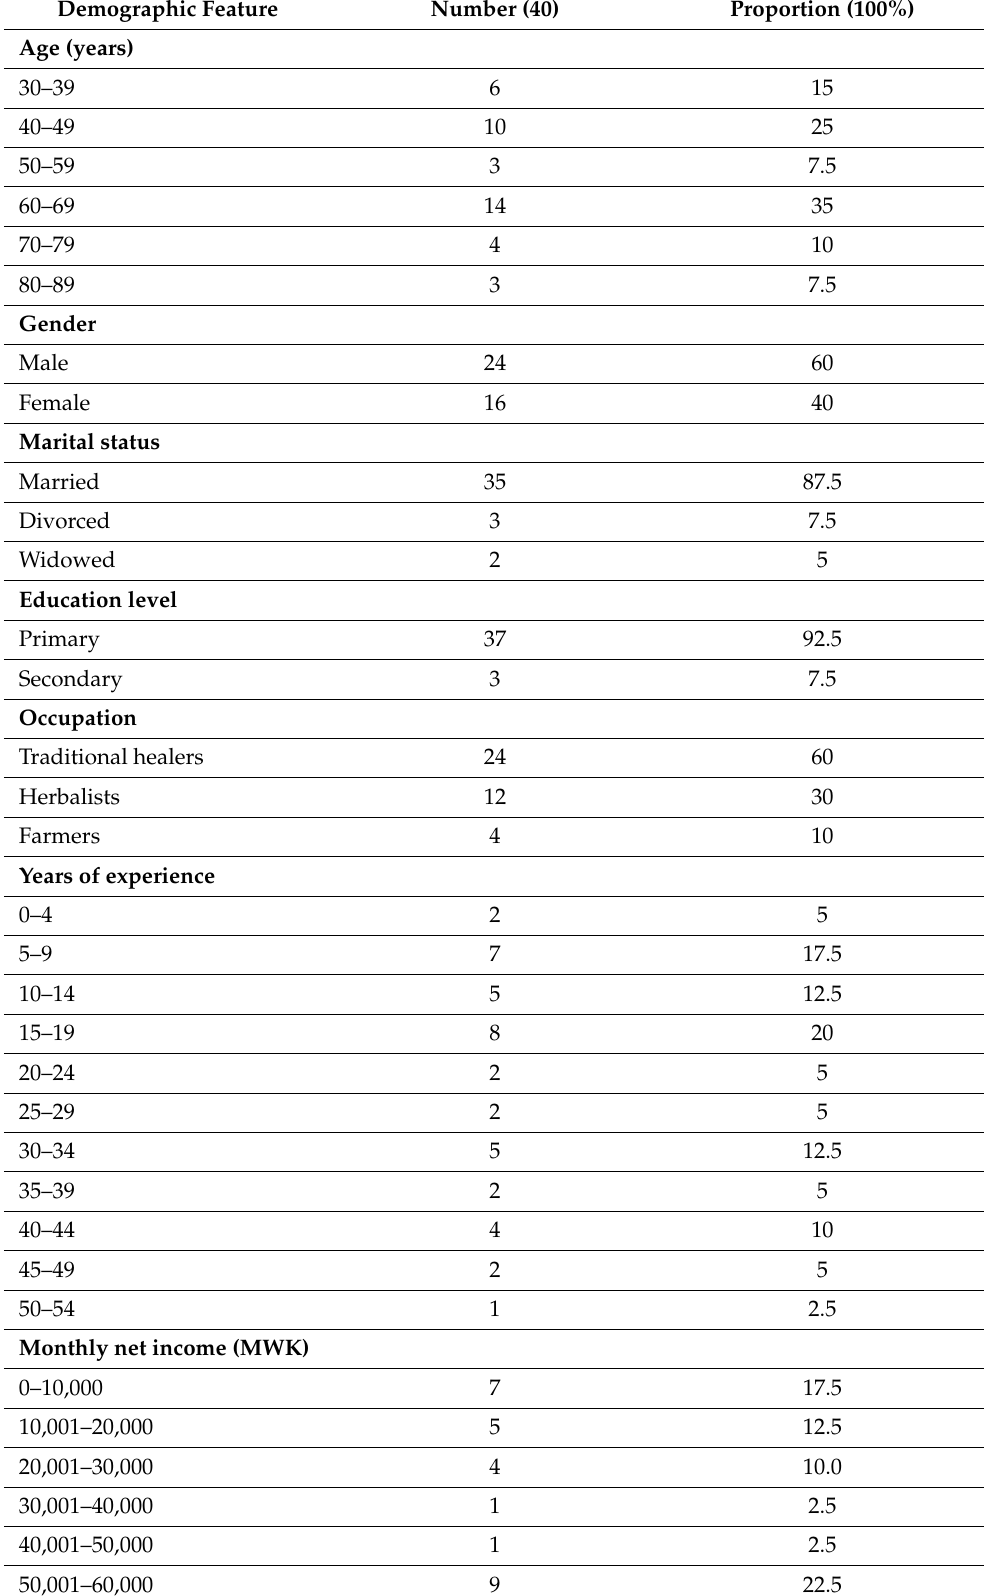
Table 1. Demographic data of respondents in the T/A Mbelwa, Mzimba District, and their localities. Demographic